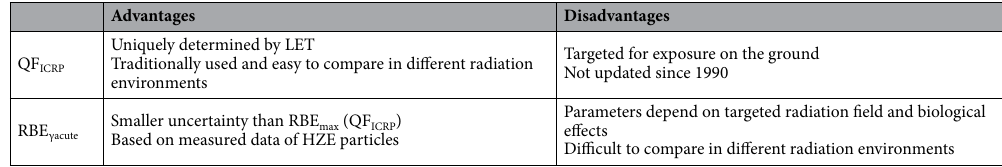
Table 3. Advantages and disadvantages for QF ICRP and RBE γacute